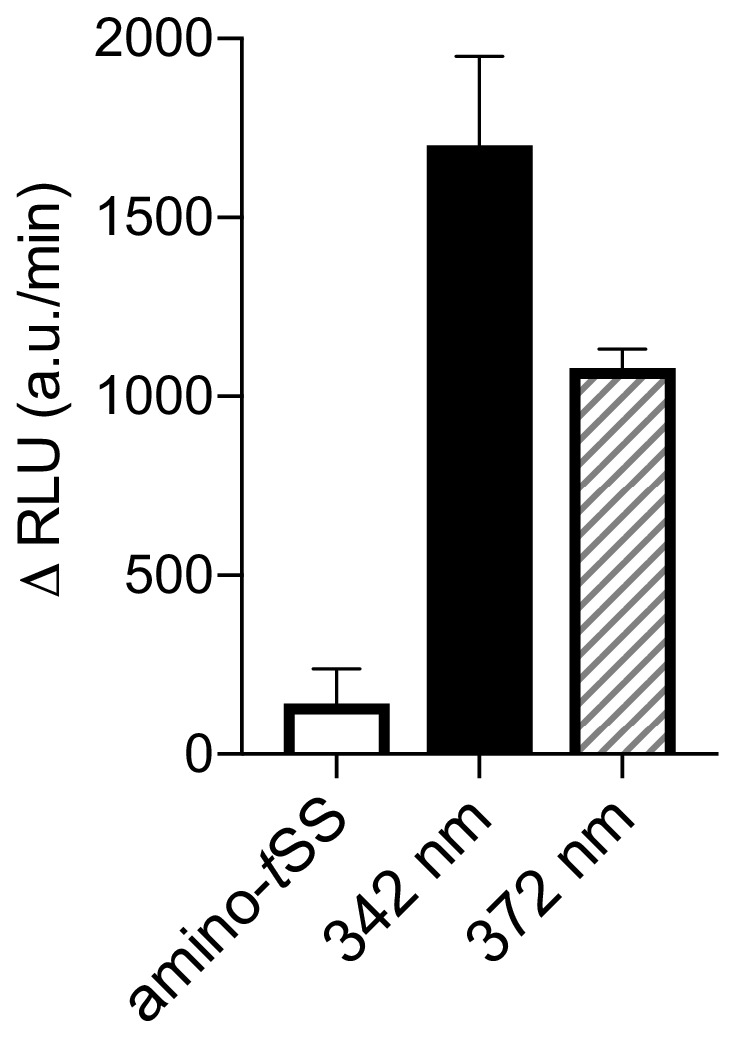
Were-1 photoregulates translation in vitro.In vitro transcription-translation reaction of Were-1-Fluc mRNA in presence of amino-tSS (left column) was irradiated at 342 nm for 60 s (Φq = 6.8*10−5 W/cm2), resulting in an increase in luciferase production (± SEM). The reaction was then irradiated at 372 nm for 60 s (Φq = 1*10−4 W/cm2), resulting in a decrease in luciferase expression rate (± SEM; Φq = 1*10−4 W/cm2) over time.Figure 3—figure supplement 2—source data 1.Photoregulation of Were-1-regulated translation in vitro.